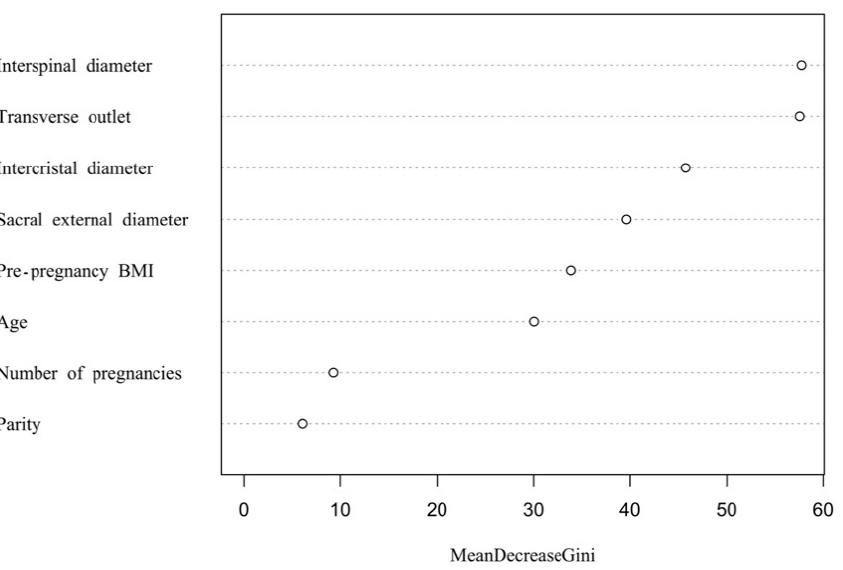
Figure 1. Change diagram of the number of decision trees and the average out-of-bag estimated error rate when establishing a random forest model.